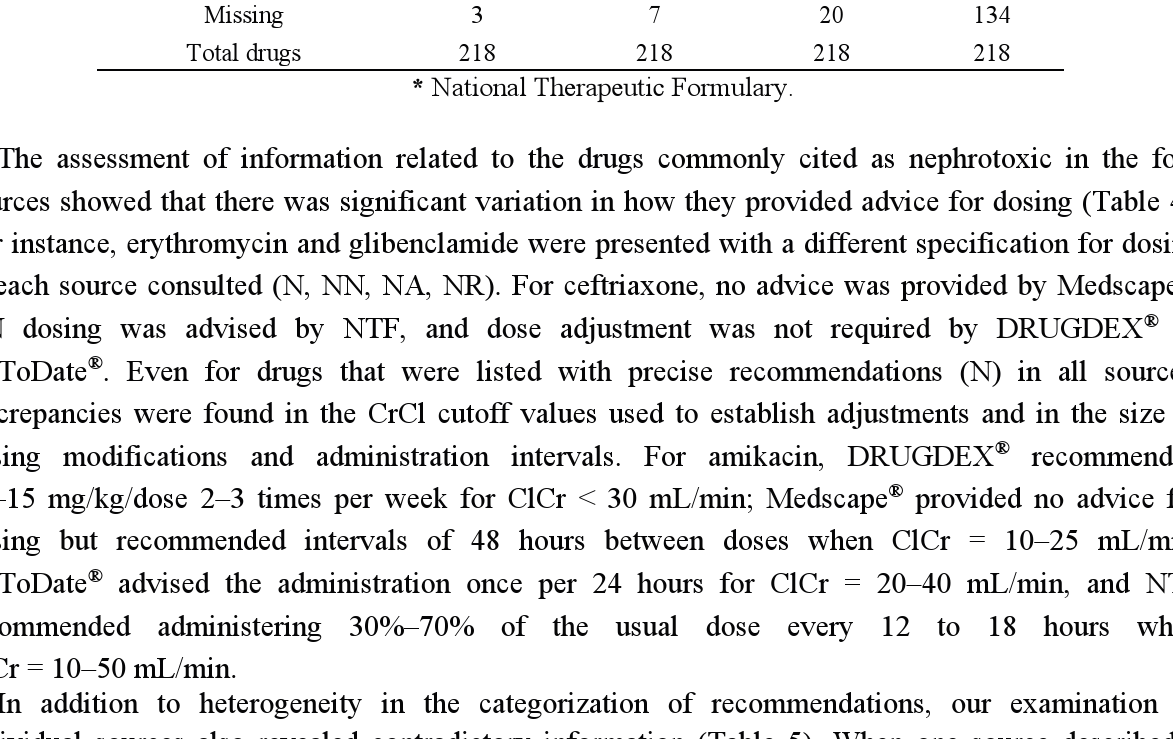
Table 3. Categories of dose adjustment recommendations for the 218 included drugs according to the four sources of information in this study. Sources Category DRUGDEX ® UpToDate ® Medscape ® NTF * Contraindicated (CI) Numerical (N) Non-numerical (NN) Not-required (NR) No advice (NA) 96 78 Missing 3 20 Total drugs 218 218 218 218 * National Therapeutic